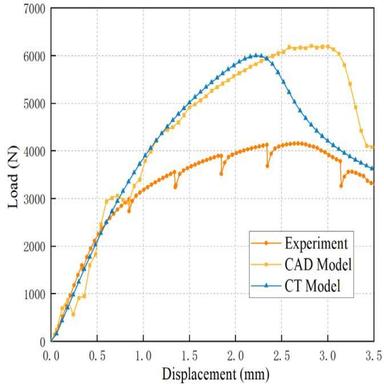
Load-displacement curves obtained by FE simulations of the CAD model and CT reconstructed model and compression test.